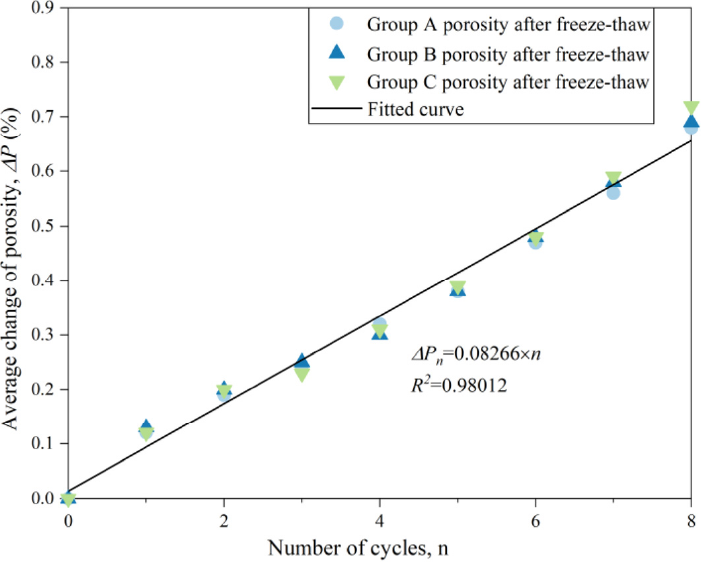
Figure 14. Relationship between the number of freeze-thaw cycles and the average change in poros- ity.